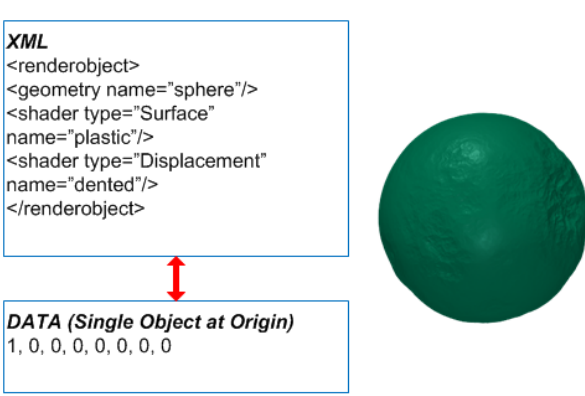
Figure 24. Simple XML for a sphere with a Surface and Displace- ment Figure 24 : Simple XML for a sphere with a Surface and Displace- ment shader. Figure 22 : An overview of the REYES Pipeline.